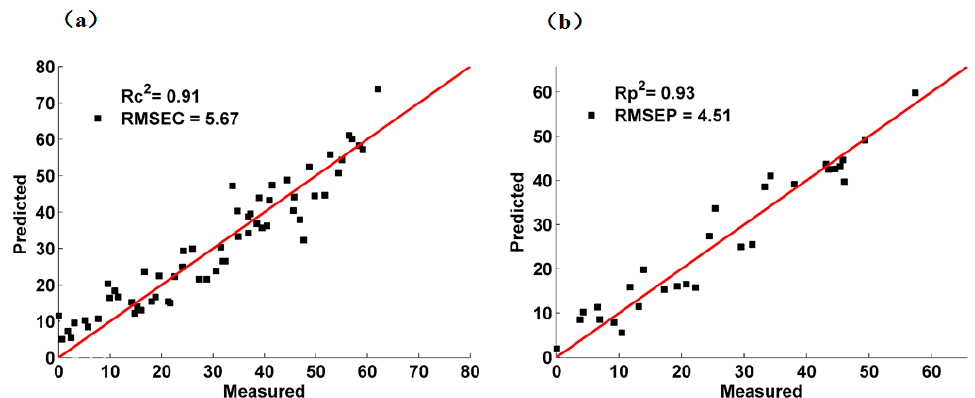
Figure 7. Scatter diagram of calibration set and prediction set by MSC: ( a ) calibration set; ( b ) prediction